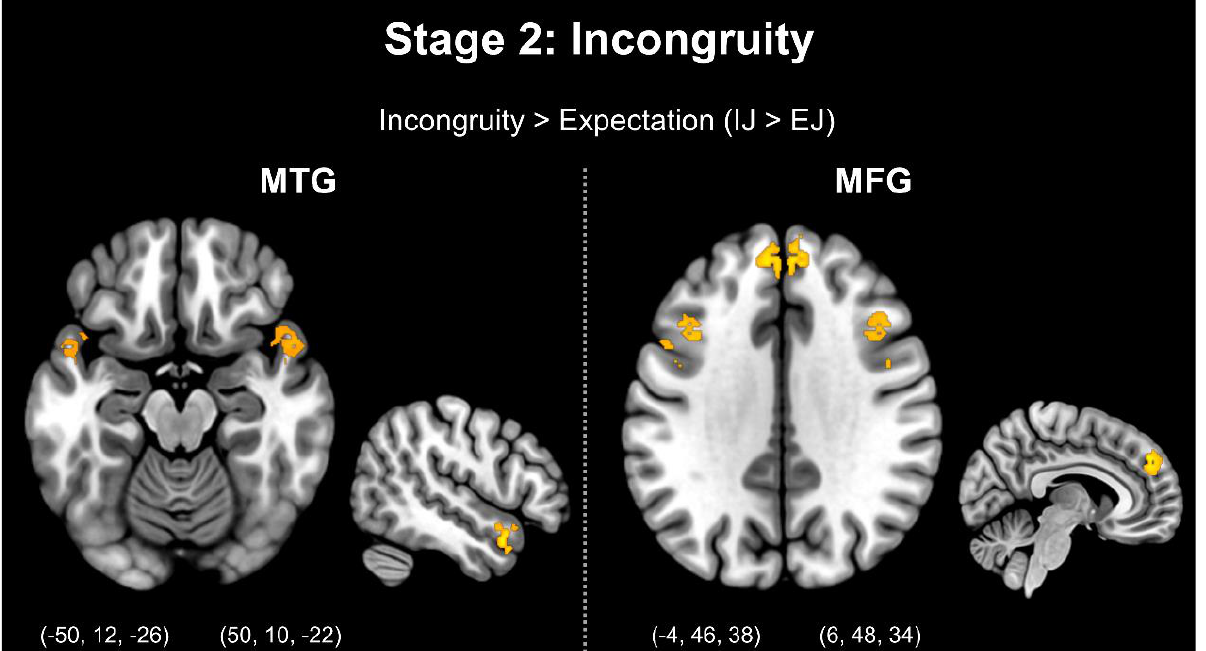
Figure 3. Stage 2: Incongruity. Note: MTG = middle temporal gyrus; MFG = medial frontal gyrus .